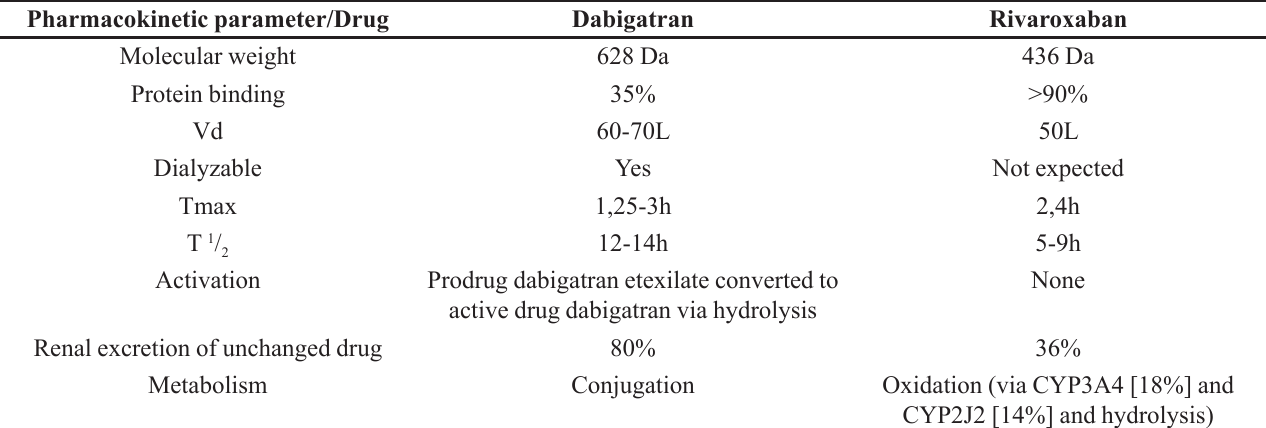
TABLE I - Comparative pharmacokinetic properties of dabigatran and rivaroxaban Pharmacokinetic